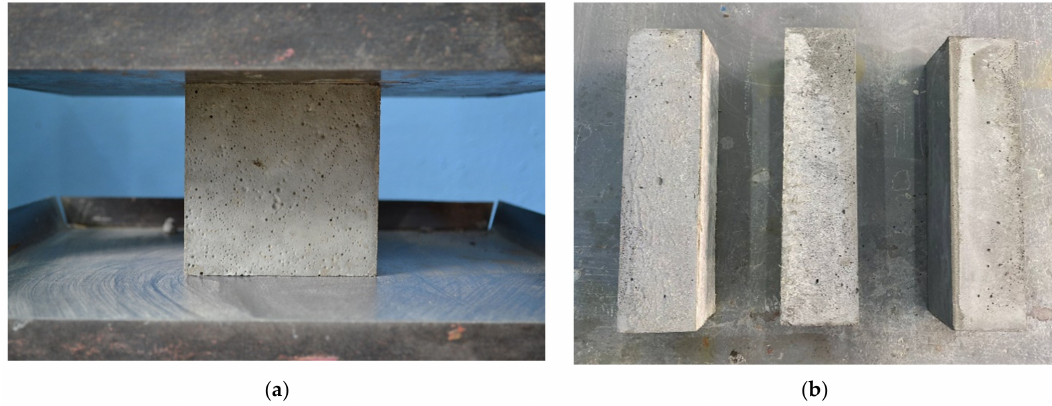
Figure 6. Test specimens: ( a ) cubes; ( b )